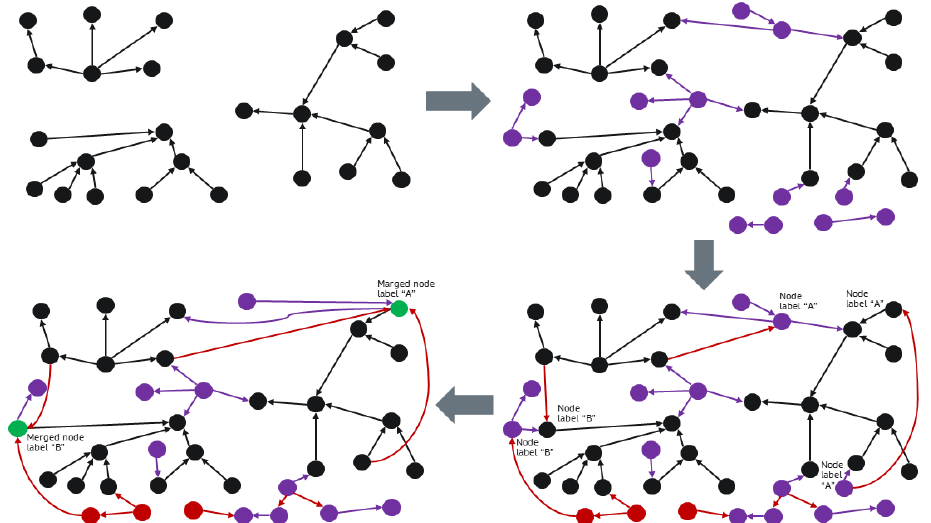
Figure 1. KG creation process. The different sources of knowledge are incorporated as nodes and edges, and those nodes with identical labels are collapsed into a single node, preserving the combination of edges. The data-driven edges are then added, linking genes among themselves or removing edges between genes and protein nodes and their annotations when there is not sufficient empirical evidence of strong interaction observed in